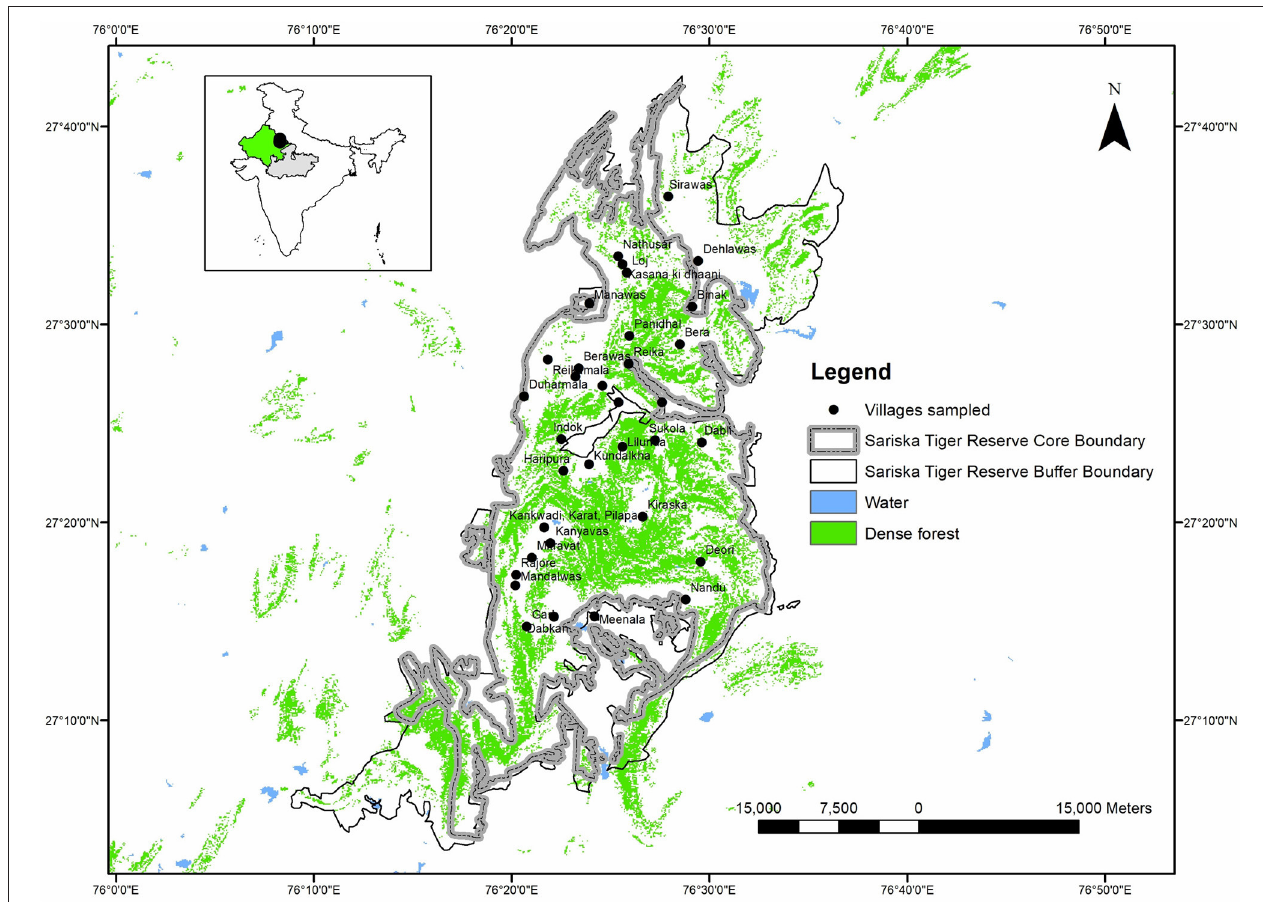
FIGURE 1 | Map showing sampled villages in Sariska Tiger